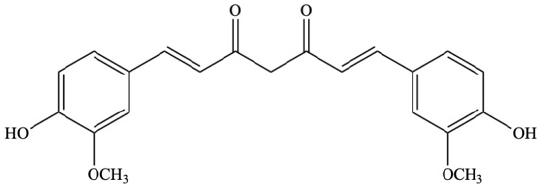
Figure 11. Chemical structure of curcumin (self ‐ generated).